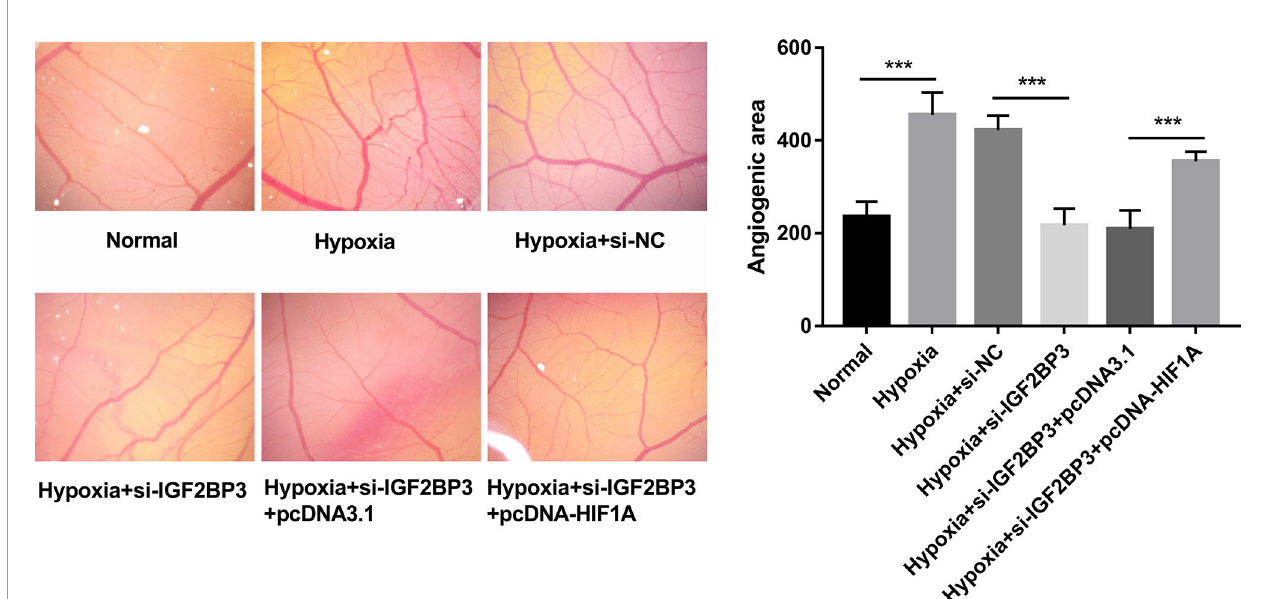
FIGURE 6 | IGF2BP3 knockdown inhibited hypoxia-induced angiogenesis by down-regulating HIF1A in vivo . MKN-45 and HGC-27 cells were transfected with si-NC, si-IGF2BP3#1, si-IGF2BP3#1+pcDNA3.1, or si-IGF2BP3#1+pcDNA-HIF1A for 48 h and then maintained in hypoxic conditions for another 24 h. Cells in the normoxia group were maintained in normoxic conditions for 72 h. Cells in the hypoxia group were cultured in normoxia for 48 h and then exposed to hypoxia for an additional 24 h. Next, the conditioned medium was collected and added to the exposed CAM. The angiogenic ability was assessed at 3 days after incubation. *** p <